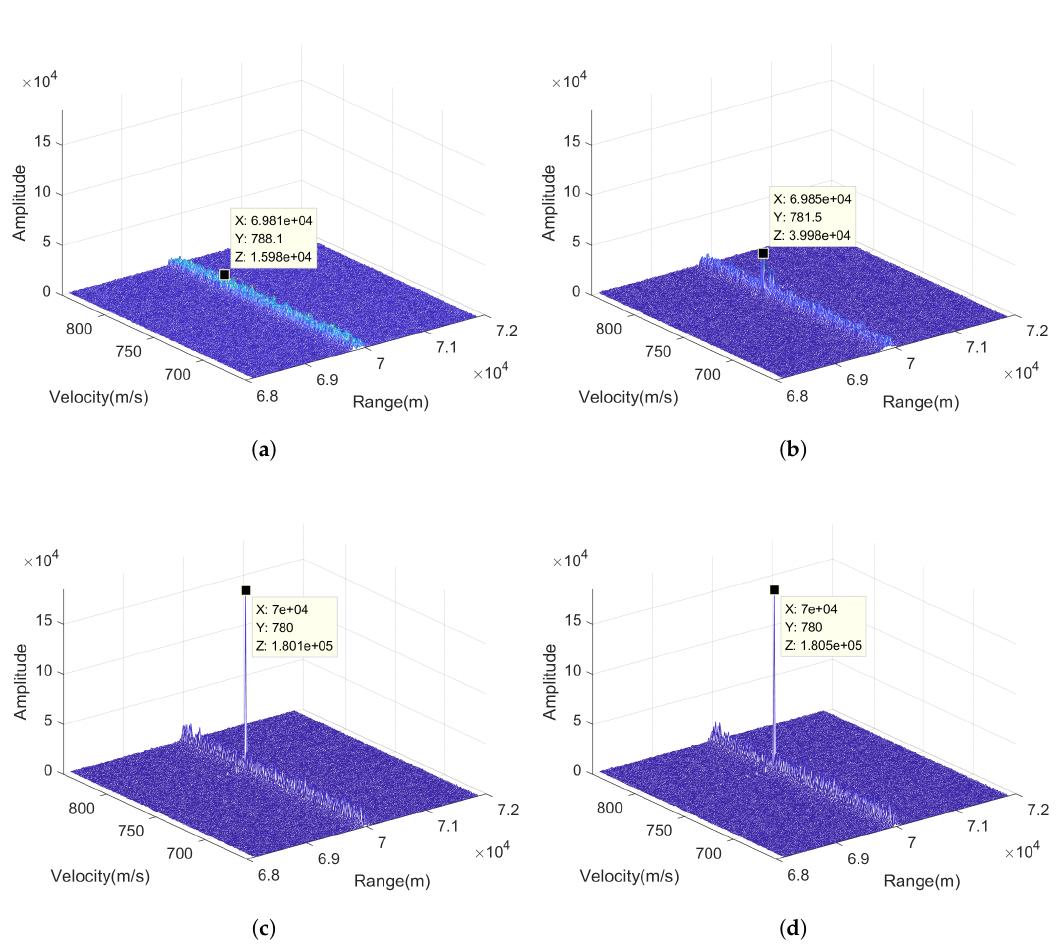
Figure 5. Coherent integration via four method: ( a ) MTD, ( b ) NUFFT, ( c ) FA-CRT, ( d ) Radon-NUFFT.